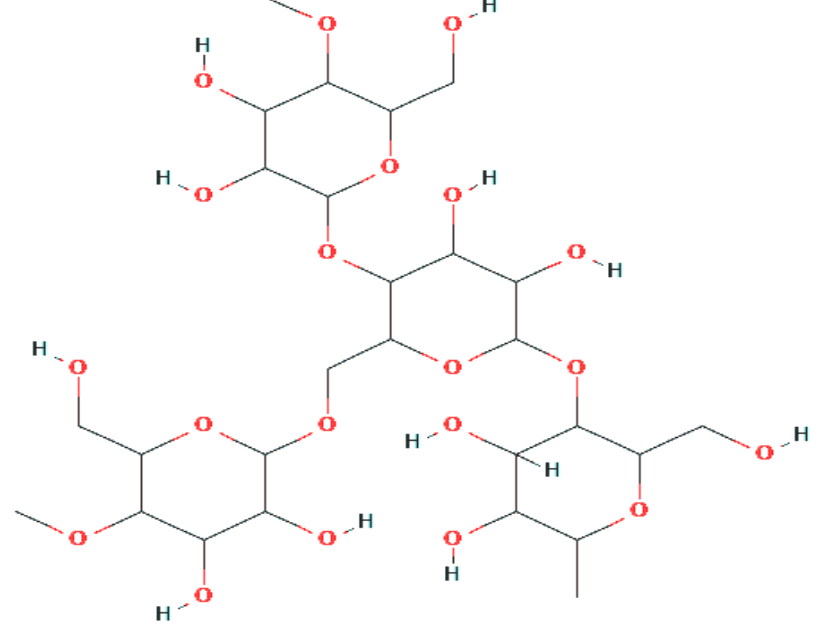
Figure 2. Basic structure of the starch molecule.